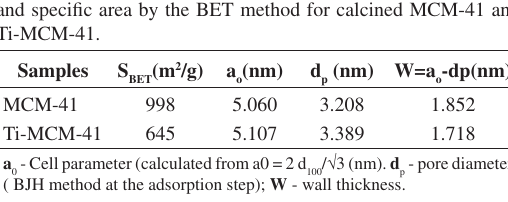
Table 2. Si-O and Ti-O bond energy. Bond